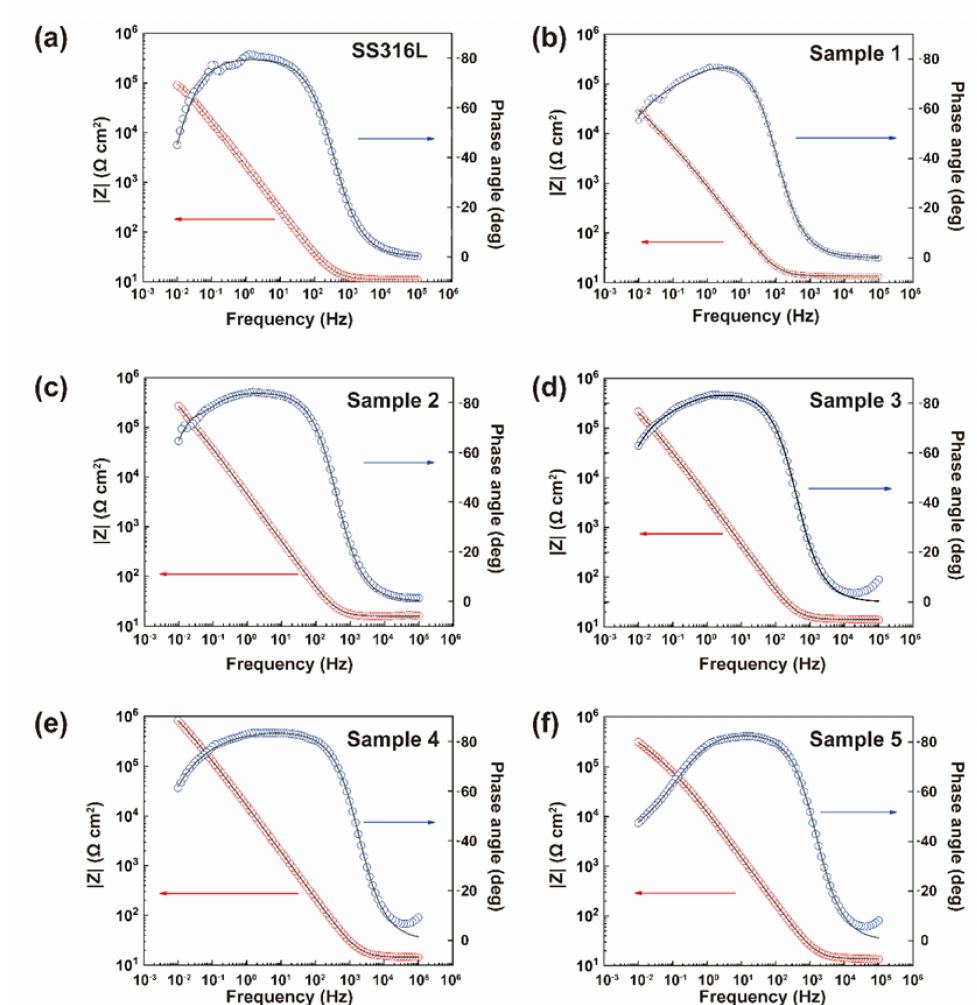
Figure 6. EIS measurements and analysis of coatings. Bode phase angle plots of ( a ) SS316L, ( b ) Sample 1, ( c ) Sample 2, ( d ) Sample 3, ( e ) Sample 4, and ( f ) Sample